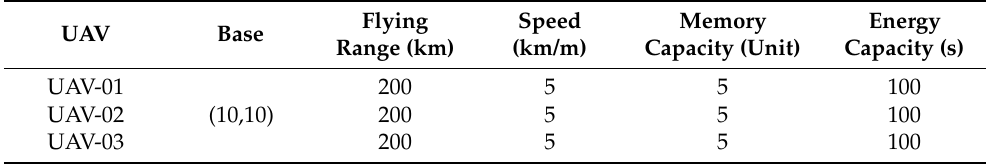
Table 2. Parameter of